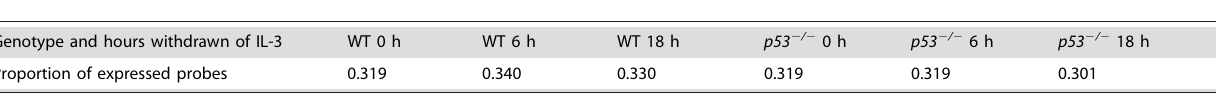
Table 1. Proportion of expressed probes for each